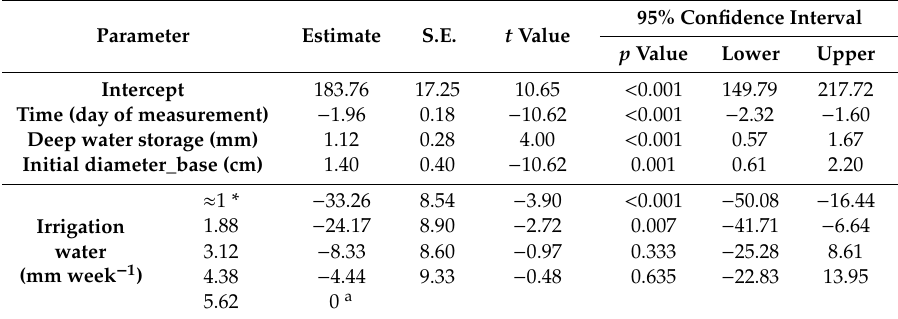
Table A3. Generalized linear mixed model (G.L.M.M.) estimates of covariance parameters on the stomatal conductance measured in 147 plants subjected to irrigation treatments, NOT grouped by “location”, in the experimental plot during the irrigation period (Summer 2016). S.E.